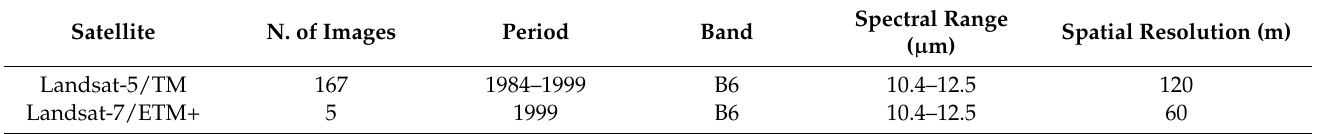
Table 4. Summary of the characteristics of the additional dataset (1984–1999) created for the scope of the